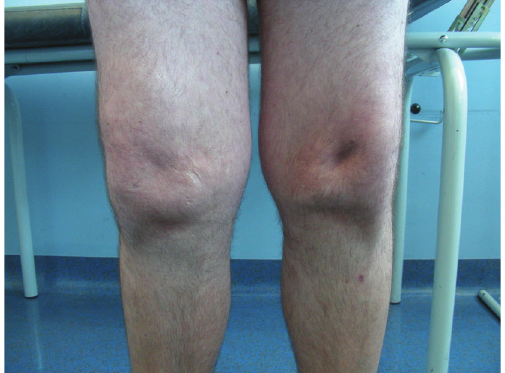
Figure 1: Clinical image of the bilateral dislocated patellae in standing position.